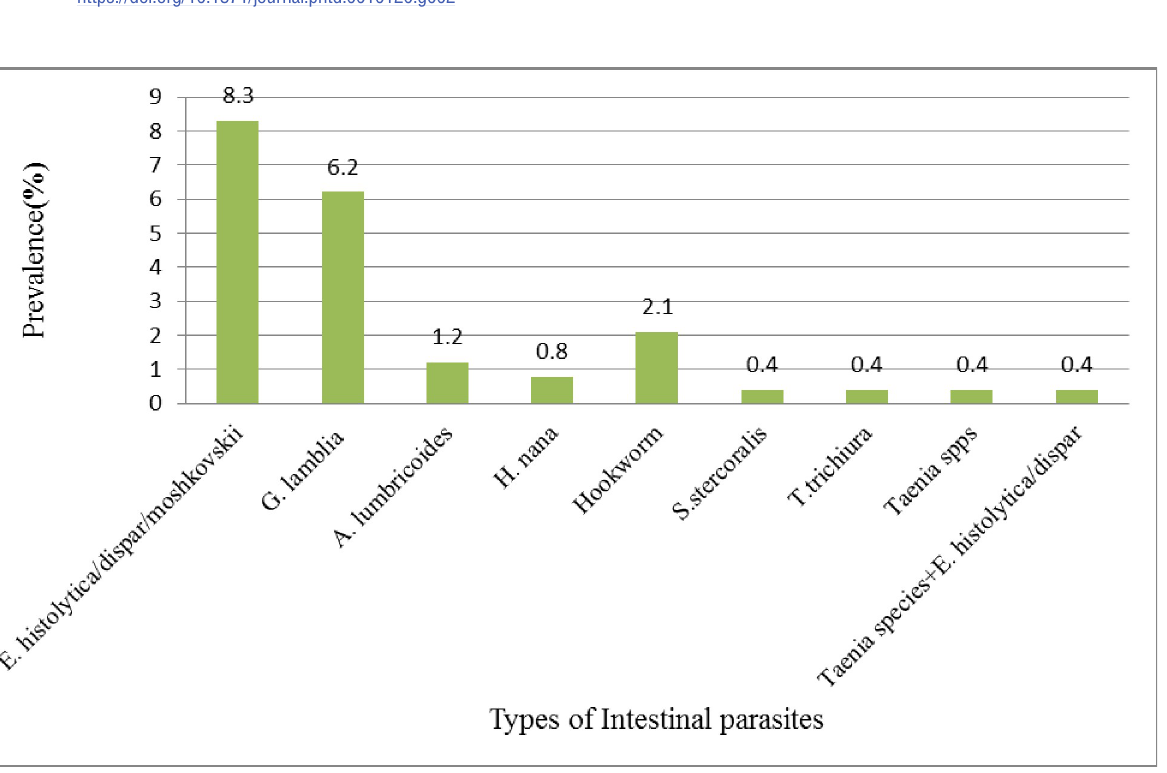
PLOS NeglectedTropical Diseases | https://doi.org/10.1371/journal.pntd.0010120 January 10, 2022 10 /